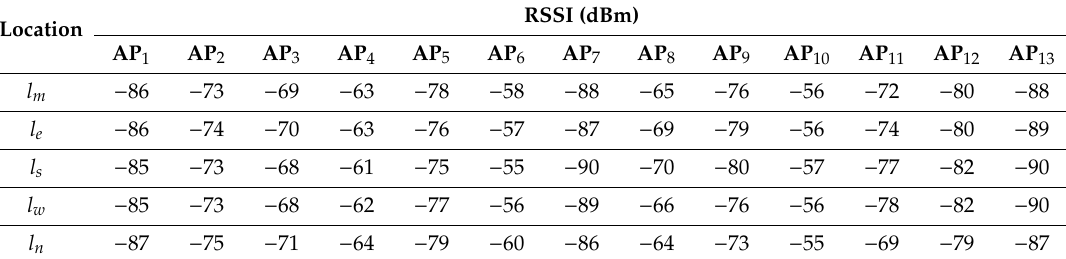
Table 1. The received signal strength indication (RSSI) samples in an indoor environment.